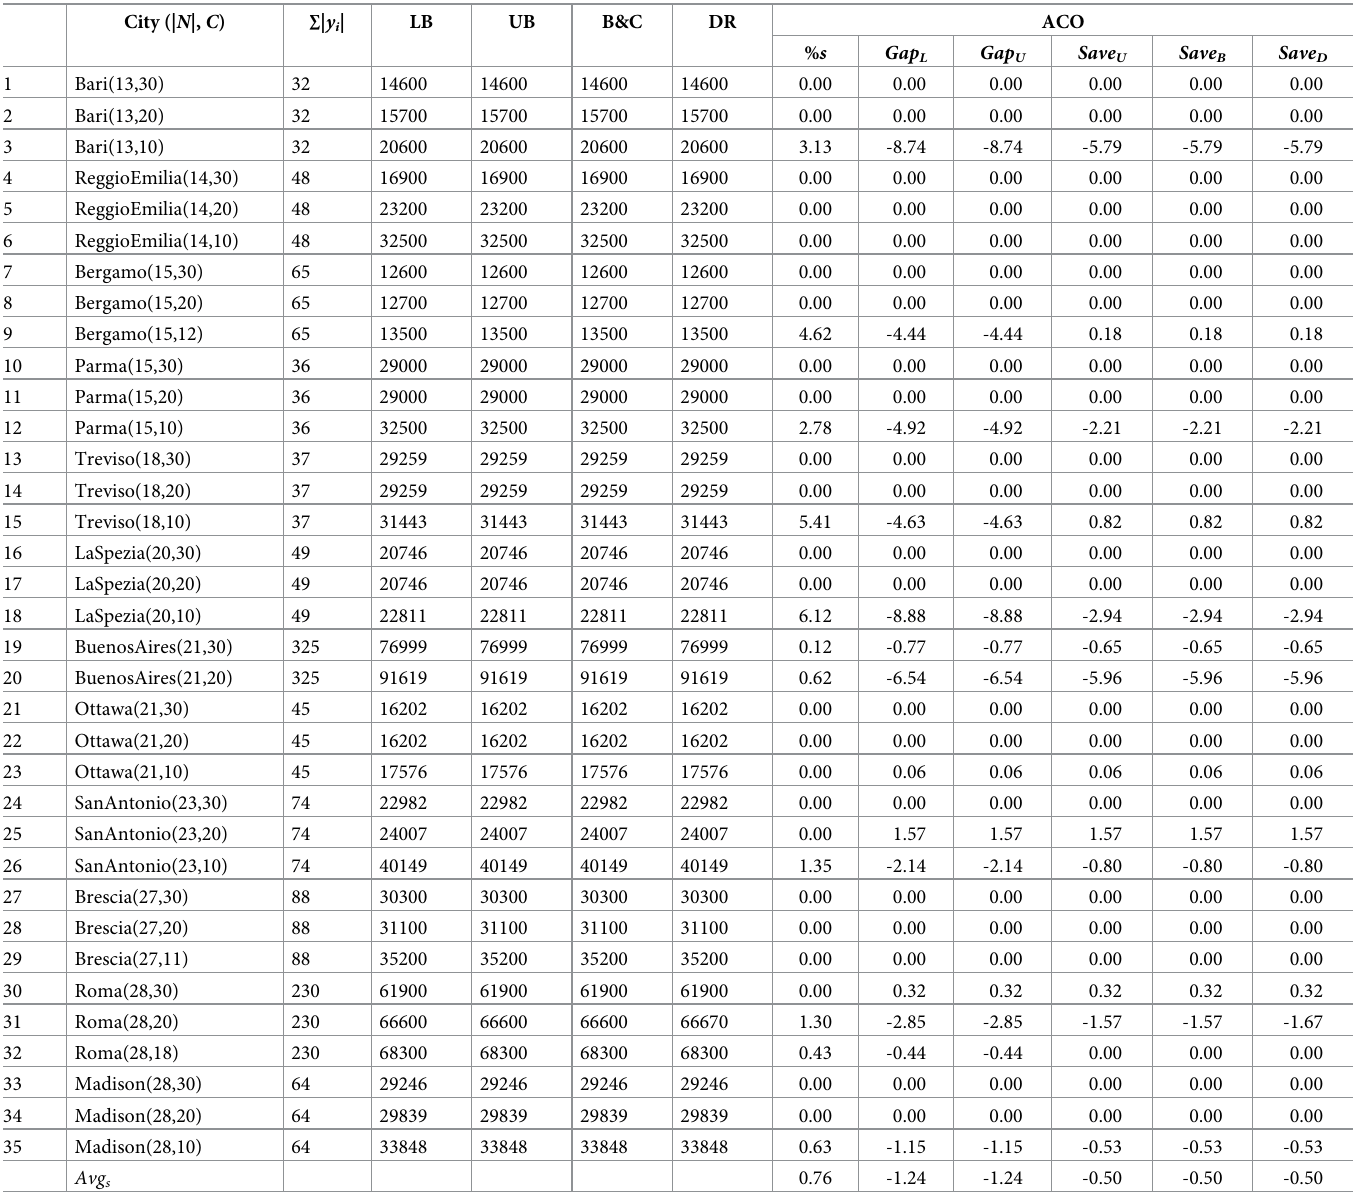
Table 1. Computational results for small-size